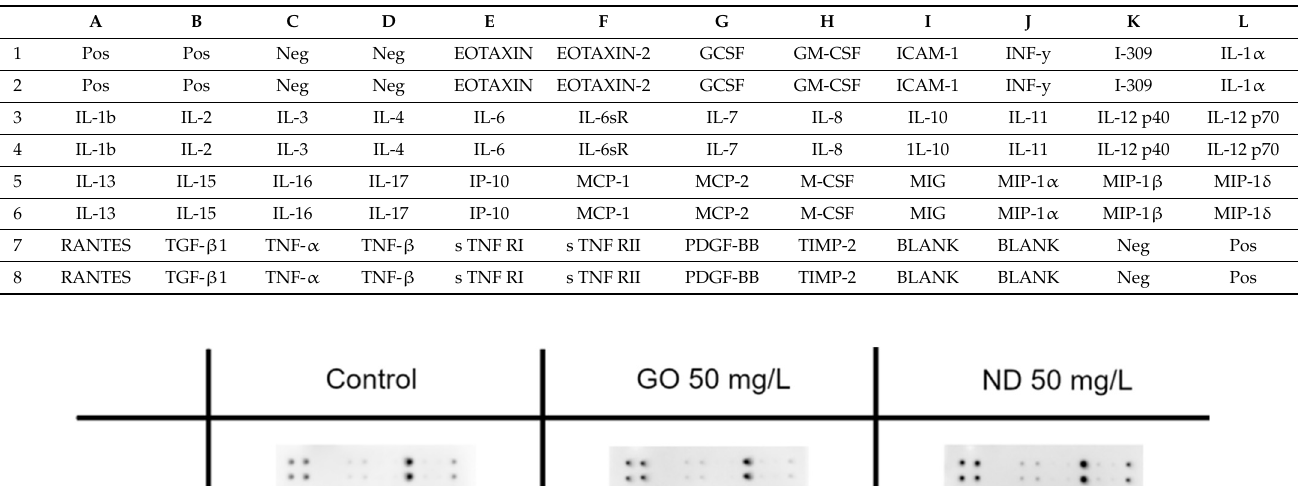
Table 2. Location of specific proteins on the membrane.